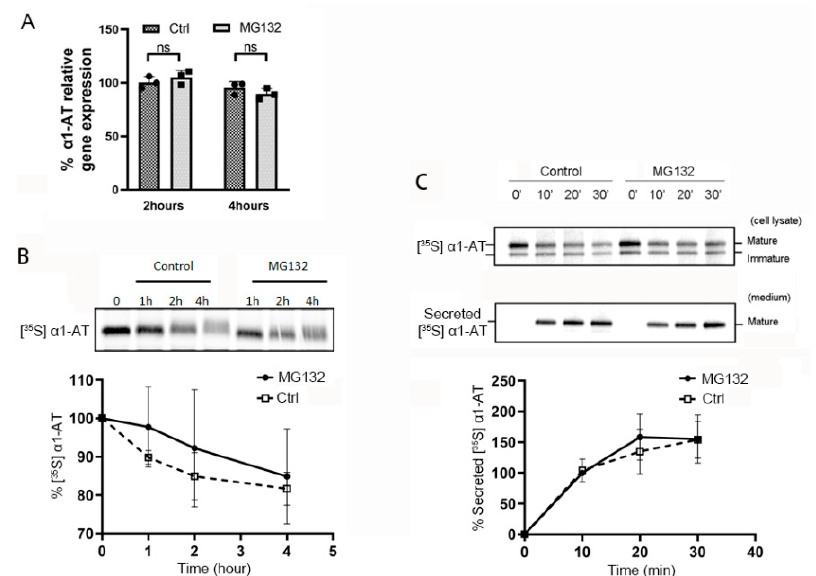
Figure 2. Proteasome inhibitor MG132 does not alter α 1AT mRNA level, degradation of α 1AT protein or its secretion during 4 h of treatment. ( A ) C3A cells were incubated for 2 or 4 h in the presence or absence of MG132 (10 µ m). Levels of α 1AT mRNA was evaluated by qPCR. ( B ) C3A cells were pulsed with [ 35 S] methionine / cysteine for 1 h and chased with unlabeled media at various time points in the absence or presence of MG132 (10 µ m). During the chase, translation and secretion of α 1AT were blocked by emetine 10 µ m and Brefeldin A (2 µ g / mL) respectively. α 1AT was immunoprecipitated and eluted proteins were analyzed by SDS / PAGE. Bands representing [ 35 S] labeled α 1AT were quantitated using phosphor-imager. Data are means ± SD, n = 3. ( C ) Hepatocyte C3A cells were first pulsed with [ 35 S] methionine / cysteine for 1 h and chased with unlabeled medium at various time points in the absence or presence of MG132 (10 µ m). α 1AT was immunoprecipitated from both cell lysates (upper panel) and culture media (lower panel) were analyzed by autoradiography. Bands representing [ 35 S] labeled α 1AT in culture media (lower panel) were quantitated by phosphor-imager. Data are means ± SD, n = 3.